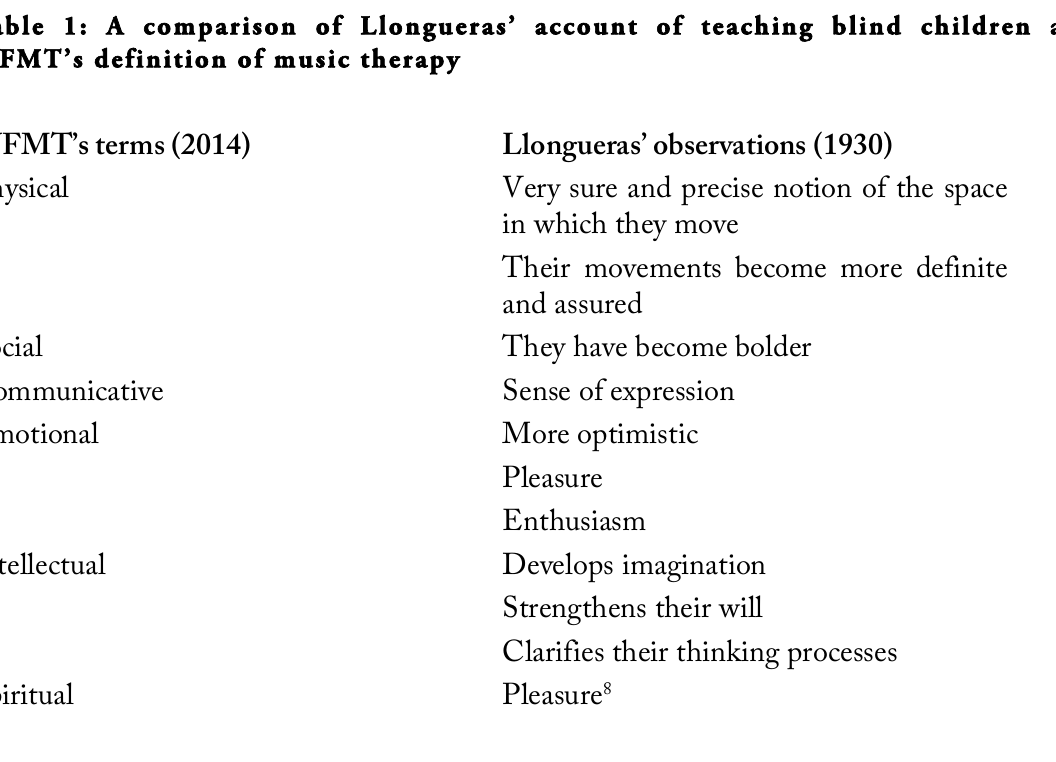
Table 1: A comparison of Llongueras’ account of teaching blind children and WFMT’s definition of music